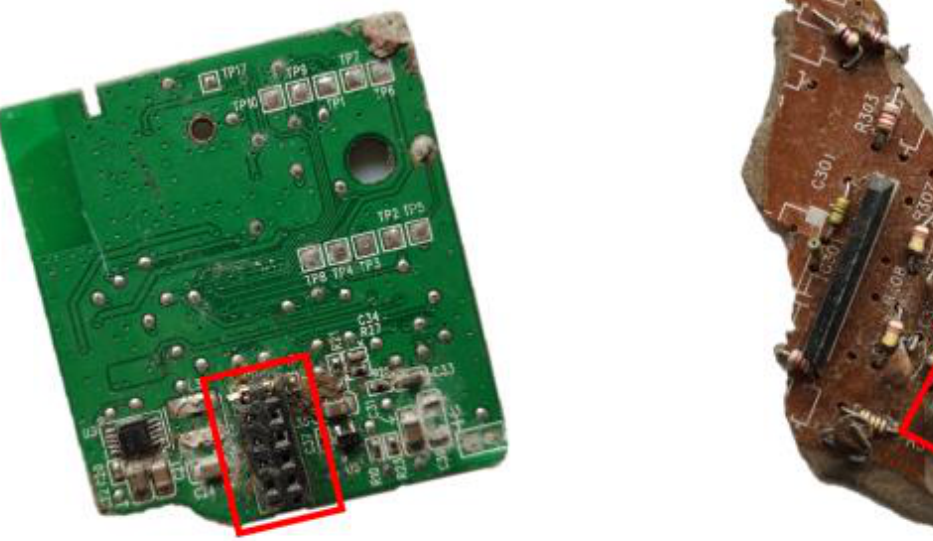
Figure 15. Misclassification due to geometric similarities in the point cloud.